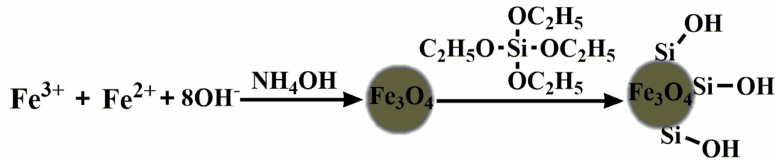
Figure 13. Synthetic route of